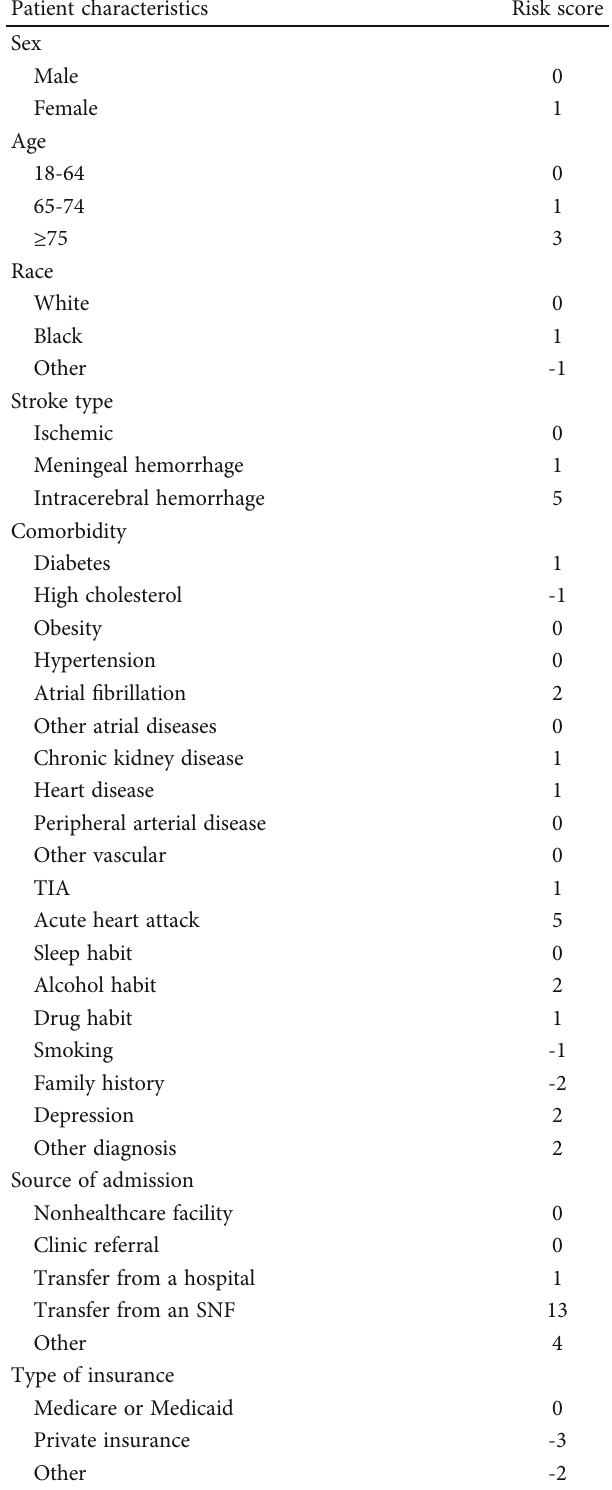
Table 5: Risk scores of patient